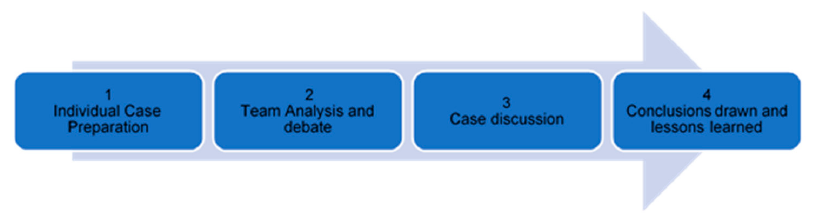
Figure 3. Steps to develop a case method learning situation. Authors’ own elaboration.